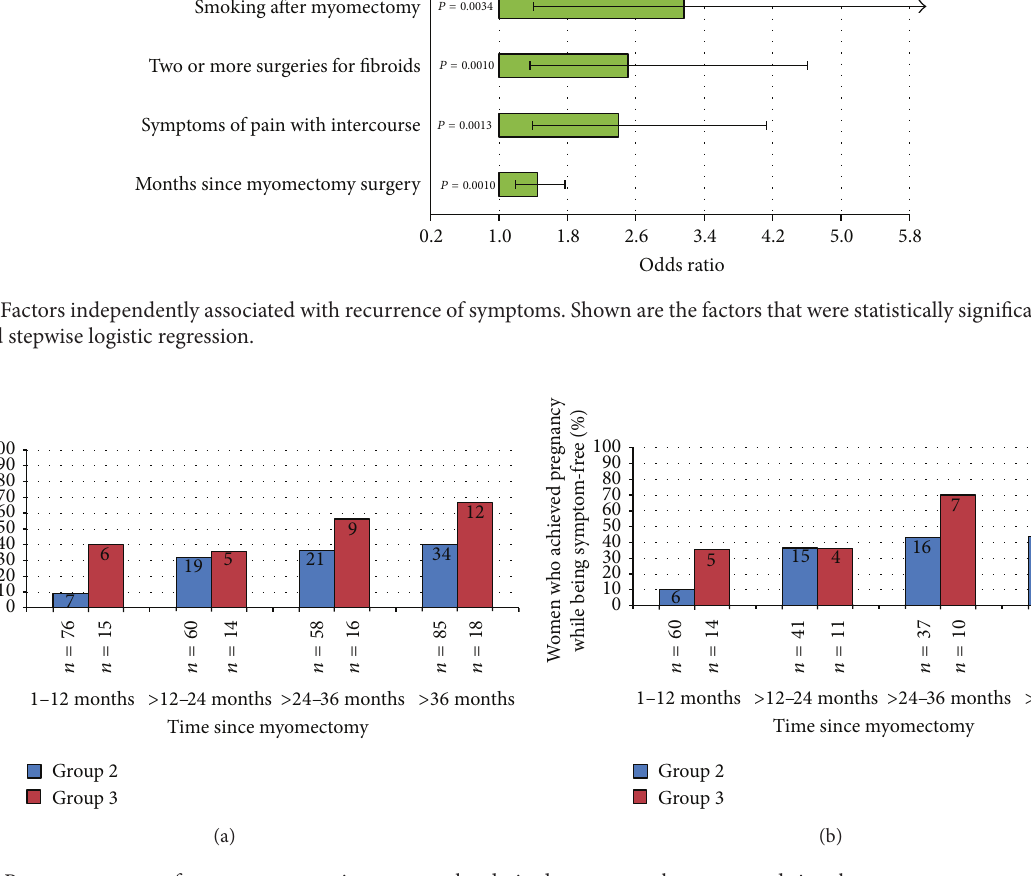
Caucasian race (OR = 1.74; 95% CI = 1.01, 3.02), longer